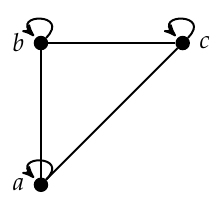
Figure 3. SBG of G